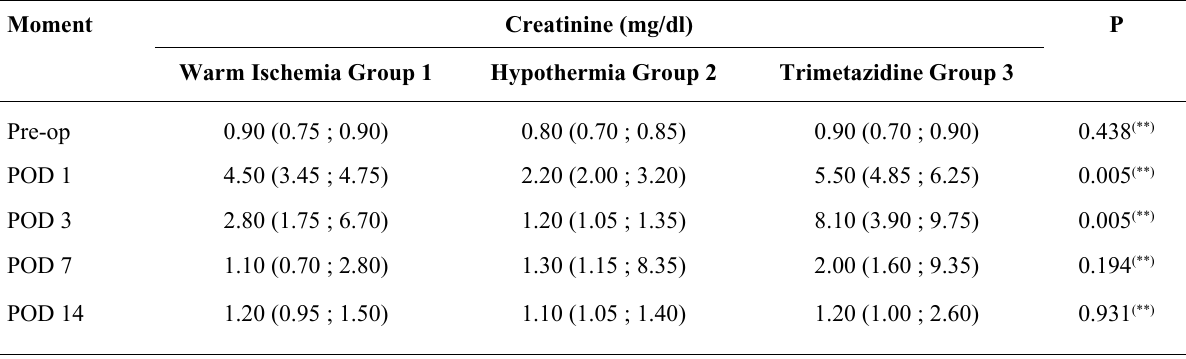
Table 2 - Creatinine values at baseline and PODs 1, 3, 7 and 14 in each group.